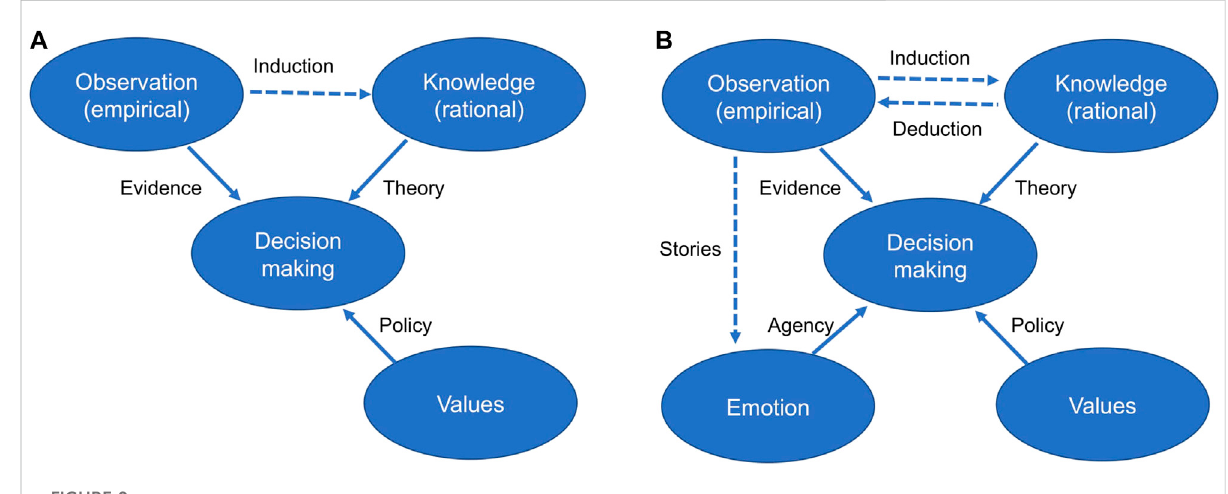
FIGURE 9 (A) : The traditional paradigm of science for decision making. (B) : The new paradigm proposed